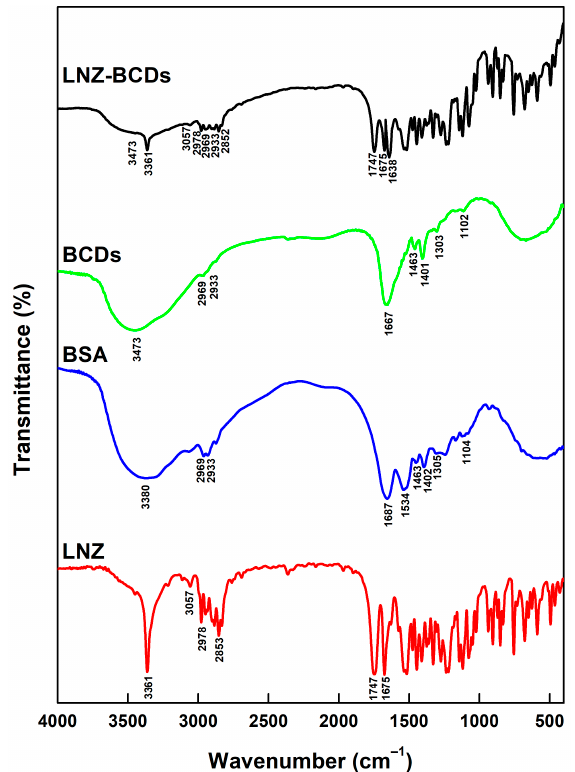
Figure 2. Fourier-transform infrared (FT-IR) spectra of the pure LNZ, pure BSA, BCDs nano-biocar- rier, and LNZ–BCDs